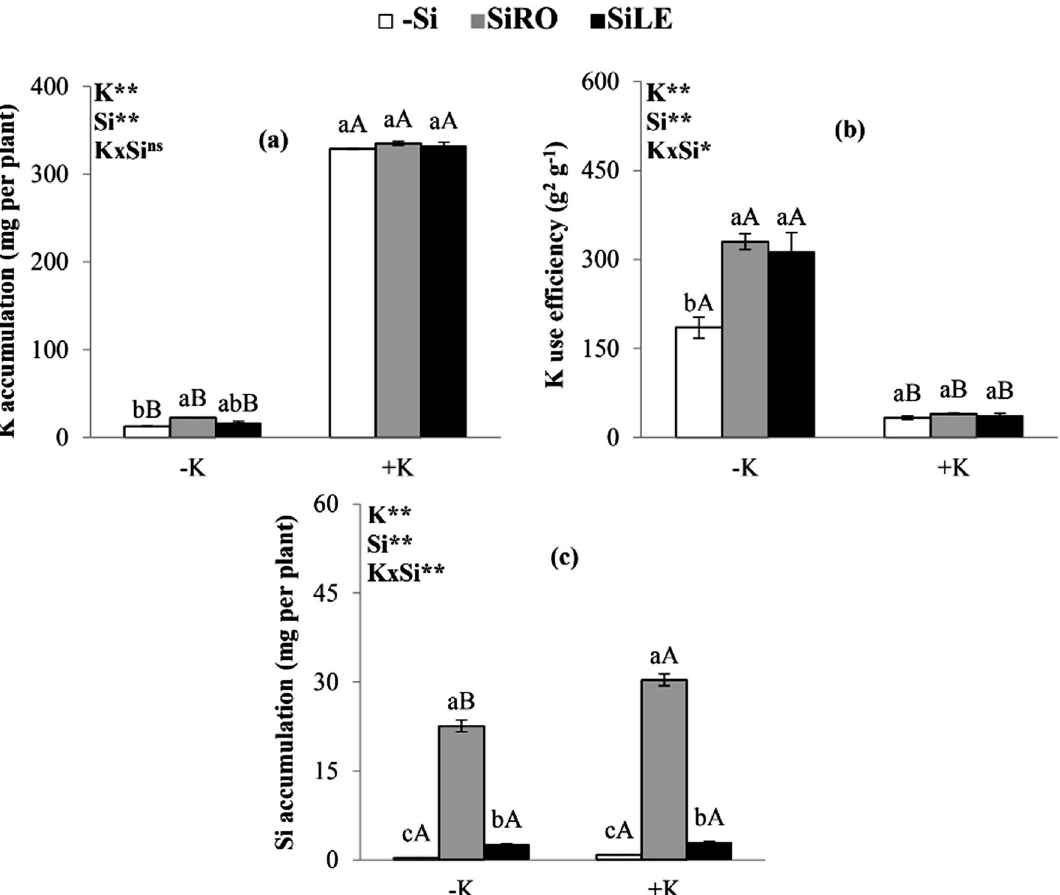
Figure 2. K accumulation (shoot + root) ( a ), K use efficiency ( b ) and Si accumulation (shoot + root) ( c ) of bean plants cultivated in a hydroponic system under deficiency (−K) and sufficiency (+K) of K, with Si supplied via nutrient solution (root) (SiRO), leaf spraying (SiLE), and control (–Si). The error bars in the figures represent standard error. Different letters, lower case between the supply of Si in the same concentration of K, and upper case between concentrations of K in the same form of supply of Si, indicate differences (P < 0.05, Tukey’s test) between Potassium-deficient beans plants when compared to K-sufficient plants had decreased Si accumulation only when Si was supplied by roots (Fig. 2c). The use of Si favoured its accumulation in bean plants with and without K deficiency, particularly when Si was supplied via SiRO compared to via SiLE (Fig. 2c). Potassium deficiency in relation to its sufficiency decreased total content of chlorophyll and carotenoids in control plants (–Si) and those under Si foliar spray. Si (Fig. 3a,b). However, in K-deficient plants, SiRO treat- ment compared to the treatments SiLE and controls (–Si) resulted in higher total contents of chlorophyll and carotenoids (Fig. 3a,b). In plants under sufficient levels of K in the nutrient solution, only those treated with SiRO had increased the total contents of chlorophyll and carotenoids (Fig. 3a,b). Bean plants cultivated in K-deficient nutrient solution exhibited chlorosis followed by necrosis on the edges of the oldest leaves. It was visually evident that this K deficiency symptom was alleviated by the supply of Si, especially provided via SiRO treatment (Fig. 3c). Plants stressed by K deficiency had increased electrolyte leakage (Fig. 4a), reduced photosynthesis rates (Fig. 4b), raised transpiration rates (Fig. 4c) and lowered relative water content (Fig. 4d) and water use efficiency (Fig. 4e) compared to plants with sufficient K levels. However, the Si supply, mainly with SiRO treatment, allevi- ated stress in K-deficient plants, as it increased photosynthesis, relative water content, and water use efficiency, in addition to minimizing transpiration rates and electrolyte leakage (Fig. 4a–e). Bean plants cultivated in K-deficient solution had reduced the leaf area (Fig. 5a), root length (Fig. 5b), root density (Fig. 5c), and root area (Fig. 5d), in addition to shoot (Fig. 5e) and root dry matter (Fig. 5f). However, K-deficient plants supplied with Si by both application methods had increased leaf area (Fig. 5a), root length (Fig. 5b), root density (Fig. 5c), and root area (Fig. 5d), as well as shoot (Fig. 5e) and root dry mat- ter (Fig. 5f), highlighting root over leaf application. On the other hand, K-sufficient plants, SiRO or SiLE only increased root density and root dry matter. These results were also visualized from photographic records of the plants (Fig. 6).